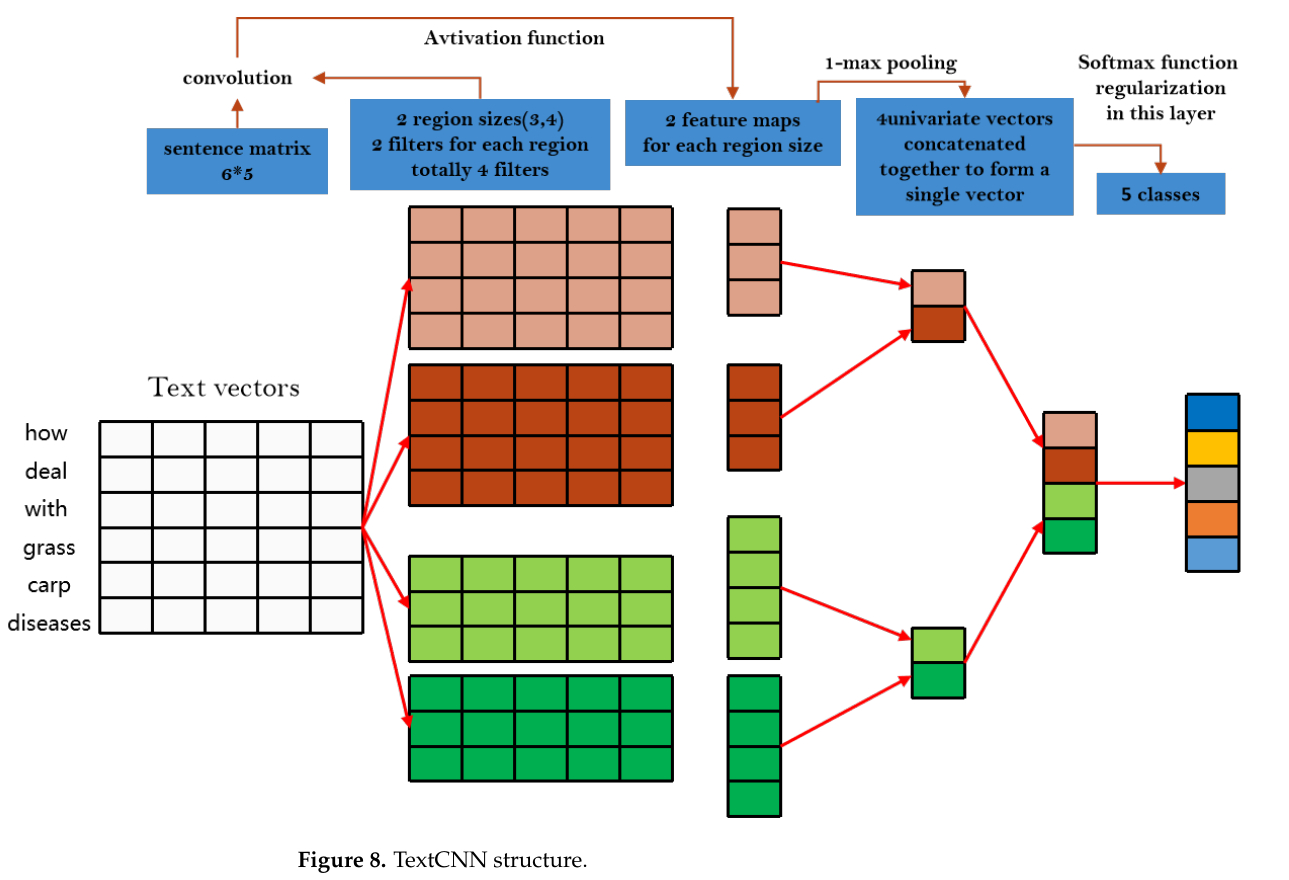
Figure 8. TextCNN Figure 8. TextCNN structure.